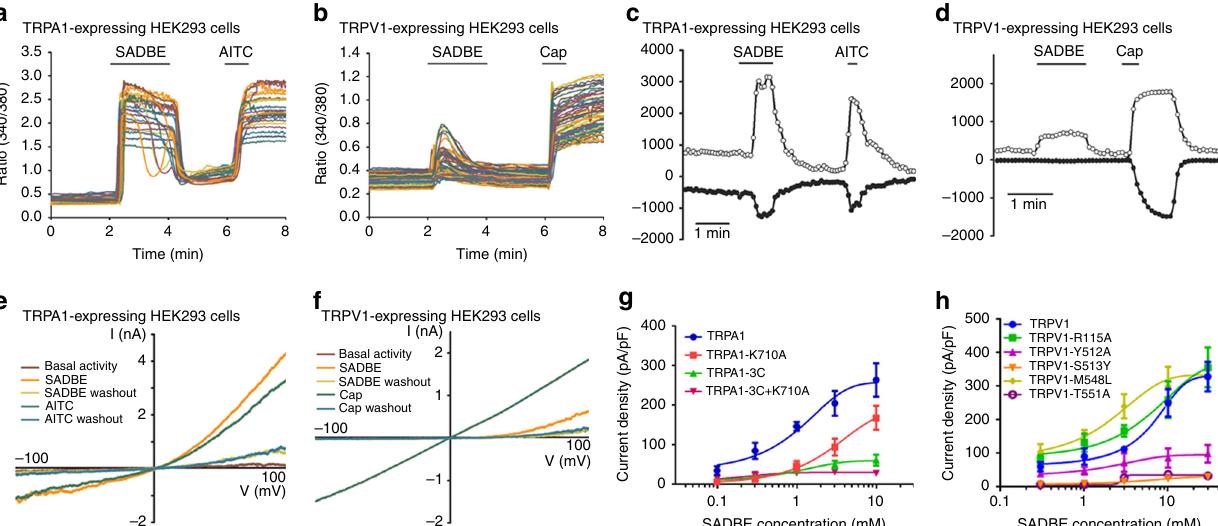
Fig. 4 Structural basis of SADBE activation of recombinant TRPA1 and TRPV1. a , b Representative time-lapse traces illustrate SADBE-elicited [Ca 2+ ] i responses in HEK293 cells transfected with TRPA1 ( a ) and TRPV1 ( b ) constructs, which could be also activated by AITC and capsaicin, respectively; c , d Representative current traces illustrate that SADBE activated large outward (at +100 mV) and inward currents (at − 100 mV) in HEK293 cells transfected with TRPA1 ( c ) and TRPV1 ( d ) constructs, which were also activated by AITC or capsaicin, respectively; e , f Representative I-V curves illustrate that SADBE-activated outwardly rectifying TRPA1 ( e ) and TRPV1 ( f ) currents. Note that the TRPA1-expressing HEK293 cell was activated by AITC and the TRPV1-expressing cell was activated by capsaicin; g Concentration – response relationships of SADBE in wild-type and mutant TRPA1 channels; h Concentration – response relationships of SADBE in wild-type and mutant TRPV1